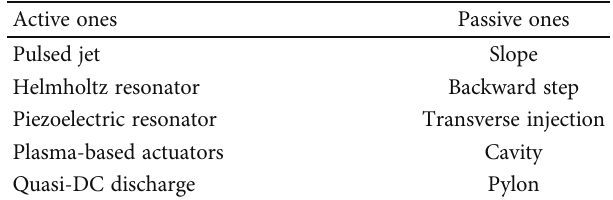
Table 1: Some common mixing enhancement methods [1 –